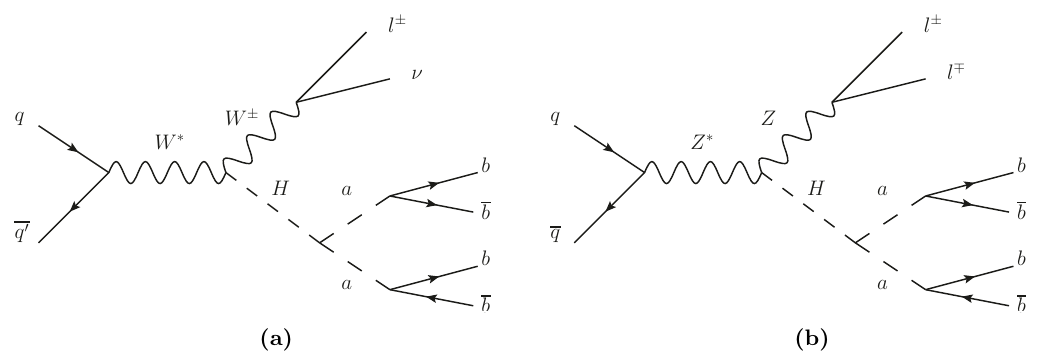
Figure 1. Representative tree-level Feynman diagrams for the (a) WH and (b) ZH